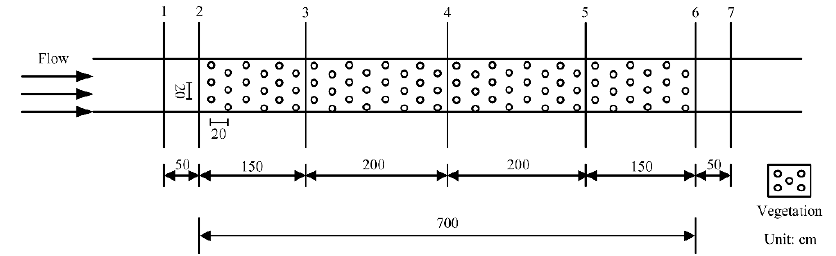
Figure 3. Locations of measurement sections in the flume.